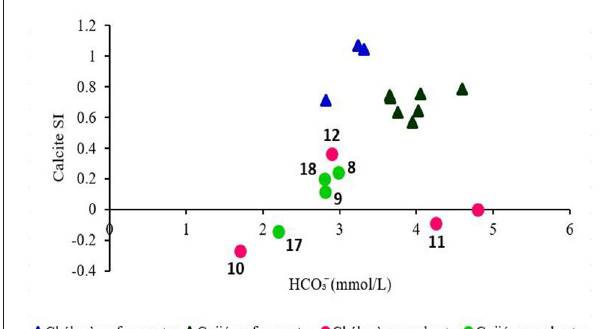
FIGURE 11 | Scatter plot of Calcite saturation index vs. bicarbonate (labels presented for groundwater samples, for location see Figure 4 ).